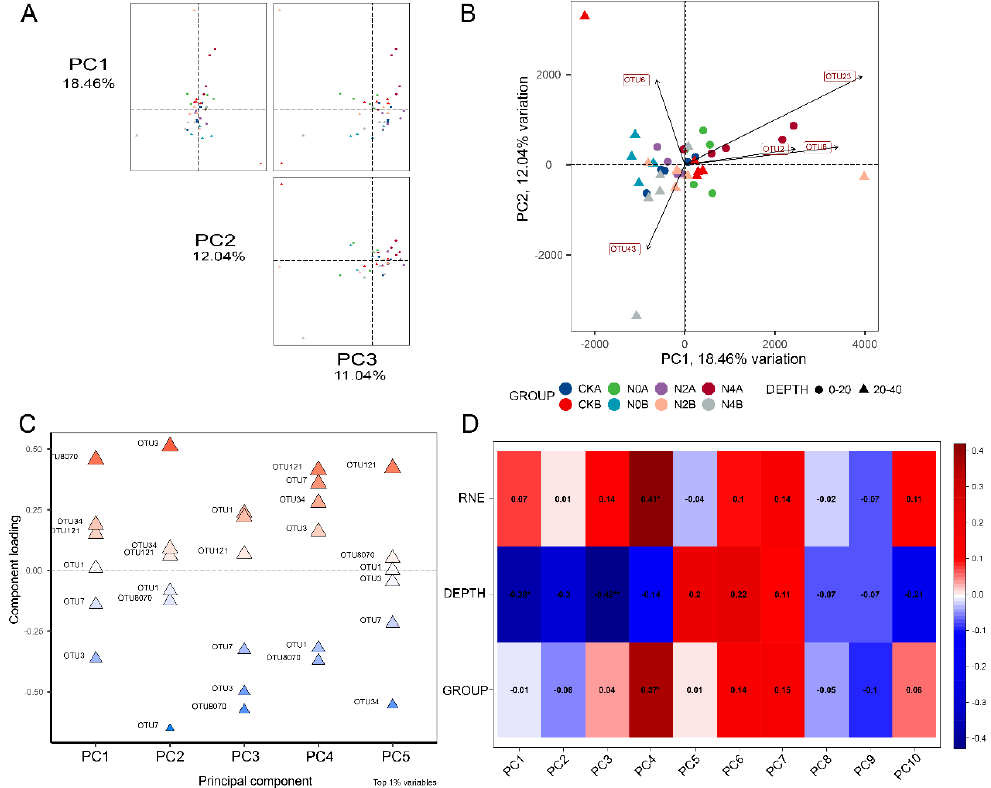
Figure 6. Fungi PCA analysis. ( A ) Score plot. The first three PCs were shown. The percentages represent the variance explanation scale. The points represent the observation sample. Treatments are shown in different colors. ( B ) Biplot. Dots represent observation samples. Circles are 0–20 cm soil. Triangles are 20–40 cm soil. RNE treatments are shown in different colors. The line segments represent the main differences OTUs. The magnitude of the angle between the line segments and the points represents the positive, negative correlation and the level. ( C ) Loadings plot. The OTUs with significant relationship with PC1–5 are shown. Redder colors represents a higher correlation. ( D ) Eigencor plot. Correlations between PC1–10 and RNE, soil depth and sample grouping were demonstrated. Red represents positive correlations and blue represents negative correlations. Darker colors represent higher correlations, * represents significance to 1 × 10 − 2 and ** represents 1 × 10 − 3